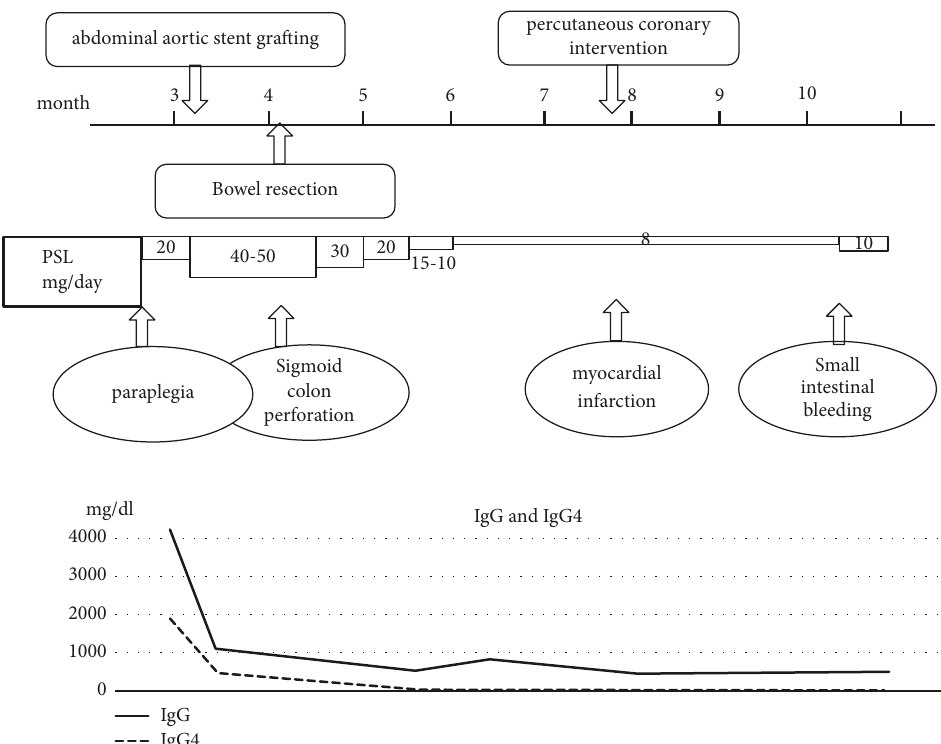
Figure 6: Progress of manifestations, IgG, IgG4, and treatments.IgG and IgG4 serumlevelsbecamenormal 1 monthafterPSL administration. PSL, prednisolone; IgG, immunoglobulin